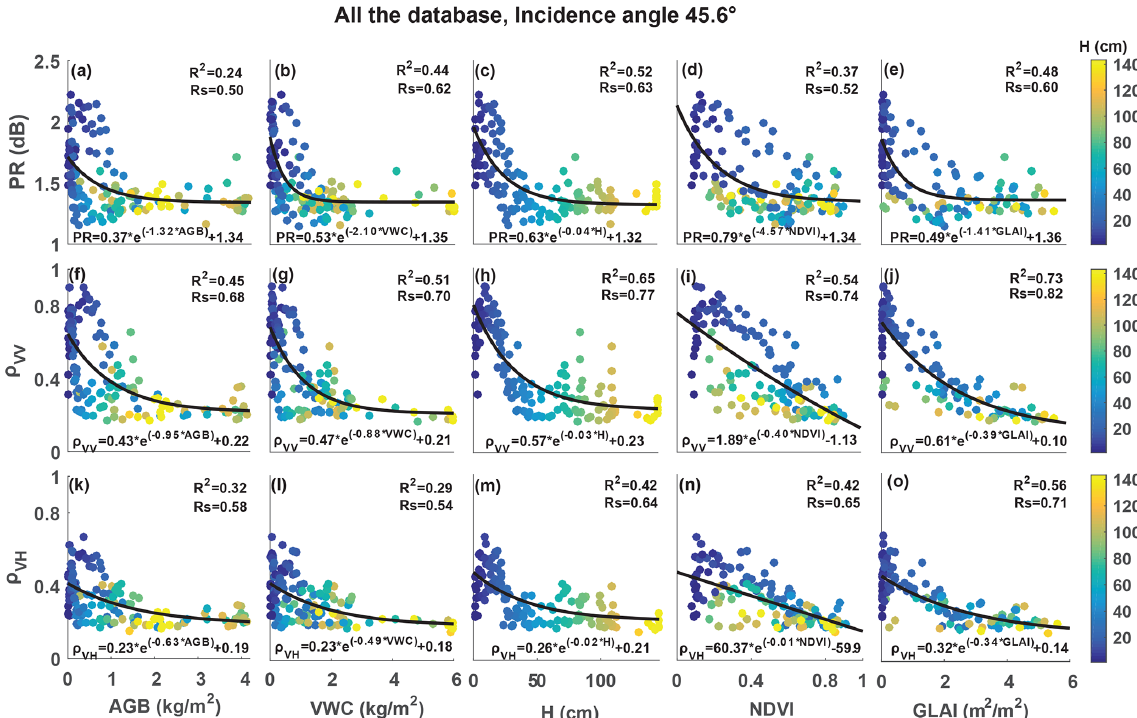
Figure A9. Scatterplots of the relationships between PR; ρ VV and ρ VH ; and AGB, VWC, H , the NDVI and the GLAI at a 45.6 ◦ angle of incidence. The entire database from the three fields (F1, F2 and F3) is used. H is used to monitor the evolution during the growing season. All the determination coefficients ( R 2 ) and the Spearman rank correlations ( R s ) are significant at